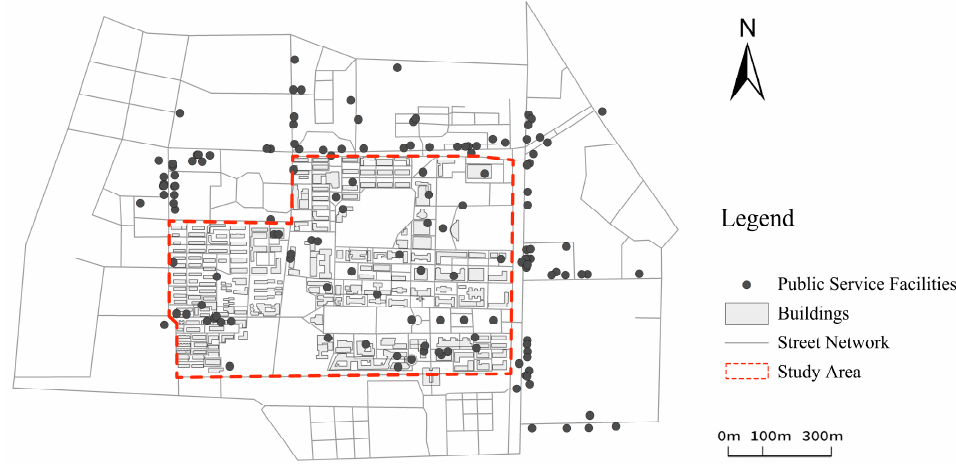
Figure 6. The map of the distribution of public service facilities within and around the campus.